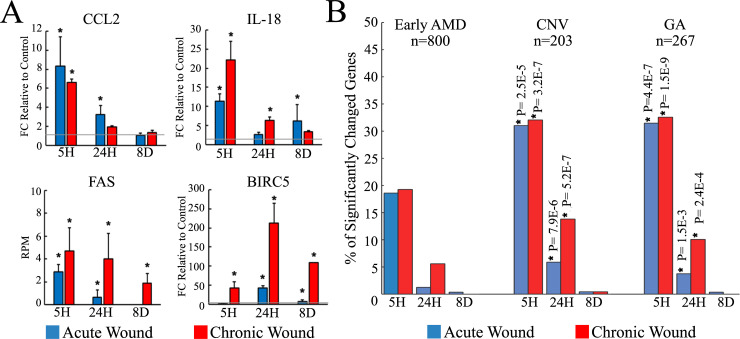
Correlation between RPE cell wounding and AMD.(A) Expression levels of selected genes. Grey line indicates the expression level of the unwounded control (mean ± SD, n = 3, * indicates p-value<0.01, see S3 Table). (B) Bar graph indicates the percentage of early AMD, CNV, and GA associated genes, whose expression levels are significantly differentially expressed (Benjamini & Hochberg correction, p-value<0.01) following acute (blue) or chronic (red) wounding. An asterisk indicates significant over-representation of CNV and GA-associated genes in wounded samples (Fisher’s exact test, p-value <0.01).